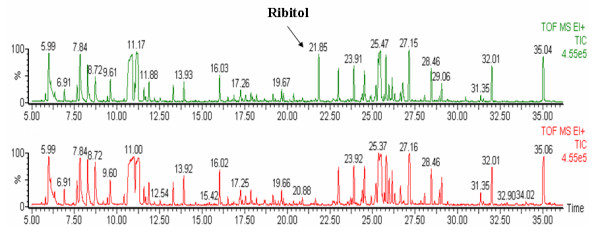
Absence of ribital in plasma samples of BALB/c mice. The peak of ribitol was showed in TIC of the sample with ribitol (upper), and there was no corresponding peak in the same retention time of TIC of another sample without ribitol (lower).